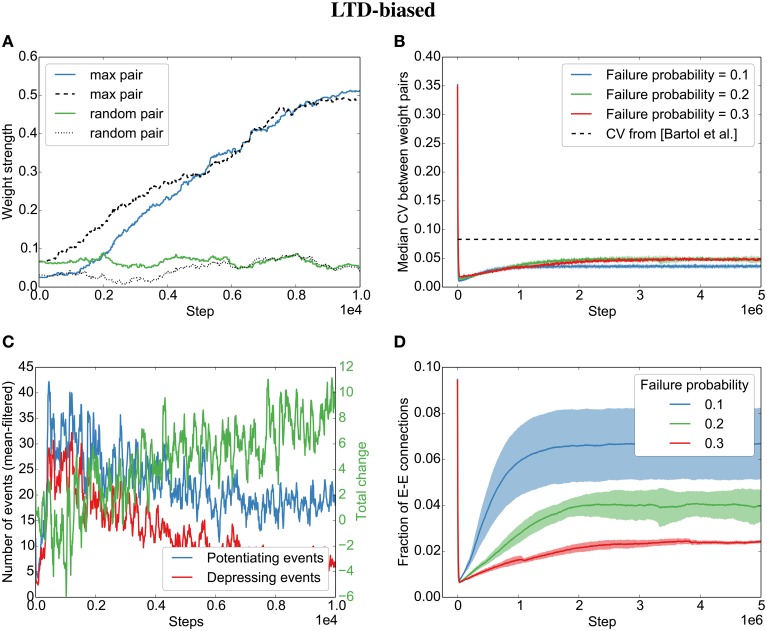
Parallel synapses align in recurrent circuits with LTD-biased STDP. The SORN model was simulated with 20% failure probability for each synapse and depression 1.25 times as strong as potentiation. (A) Parallel synapses align. The pair with the maximal final mean weight (blue and dashed) and a randomly selected pair (green and dotted) are plotted for the beginning of the simulation. (B) The CV drops below the experimentally reported values for different failure probabilities. (C) STDP dynamics at the beginning of the simulation. After a short initial period, there are fewer depressing events (red line) than potentiating events (blue line) and the total weight change due to STDP becomes positive (green line). (D) The overall fraction of excitatory-to-excitatory connections converges and follows a qualitatively similarly fast decay and slow increase as reported in the original paper (Zheng et al., 2013) for different failure probabilities. Shaded areas are standard deviations over five independent simulations.